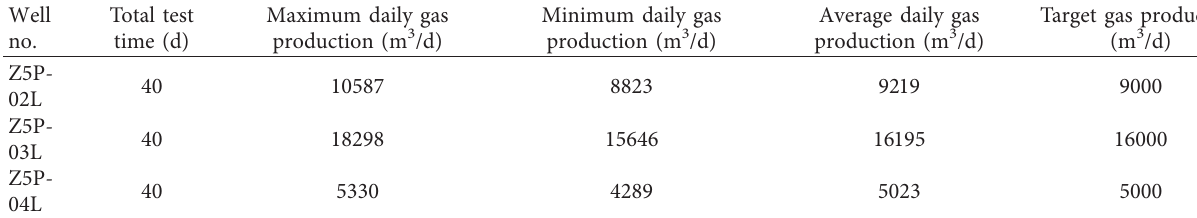
Table 4: Gas production data in the productivity test stage.